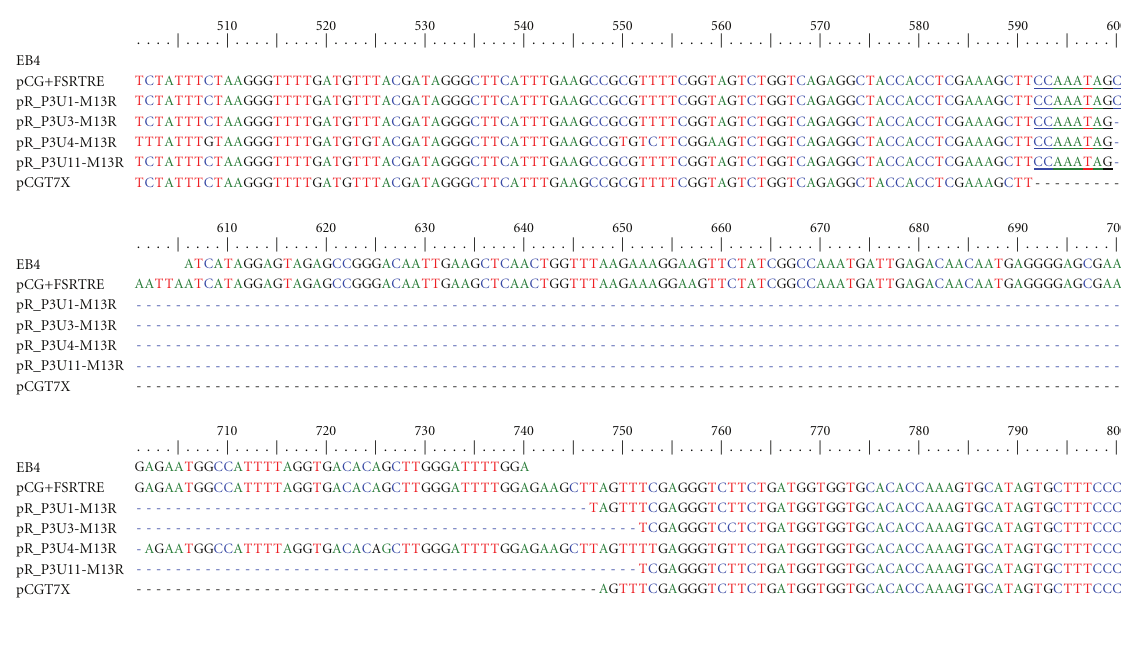
Figure 7: Sequence alignments of cloned RT-PCR-amplified products from putative chimeric CGMMV RNA at 30dpi. Plasmid clones sent for sequence analysis were pR P3U1, pR P3U3, pR P3U4, and pR P3U11. The sequence alignment shows that EB4 sequence was not within the insert of plasmids, except for a partial sequence for pR P3U4 clone. Only part of the downstream sequence of EB4 was detected together with 3 (cid:4) untranslated region of CGMMV for pR P3U4 clone, the rest were without EB4 sequence. Introduced read-through sequences and extra codons are underlined. Complete EB4 sequence is aligned accordingly with the other sequences.